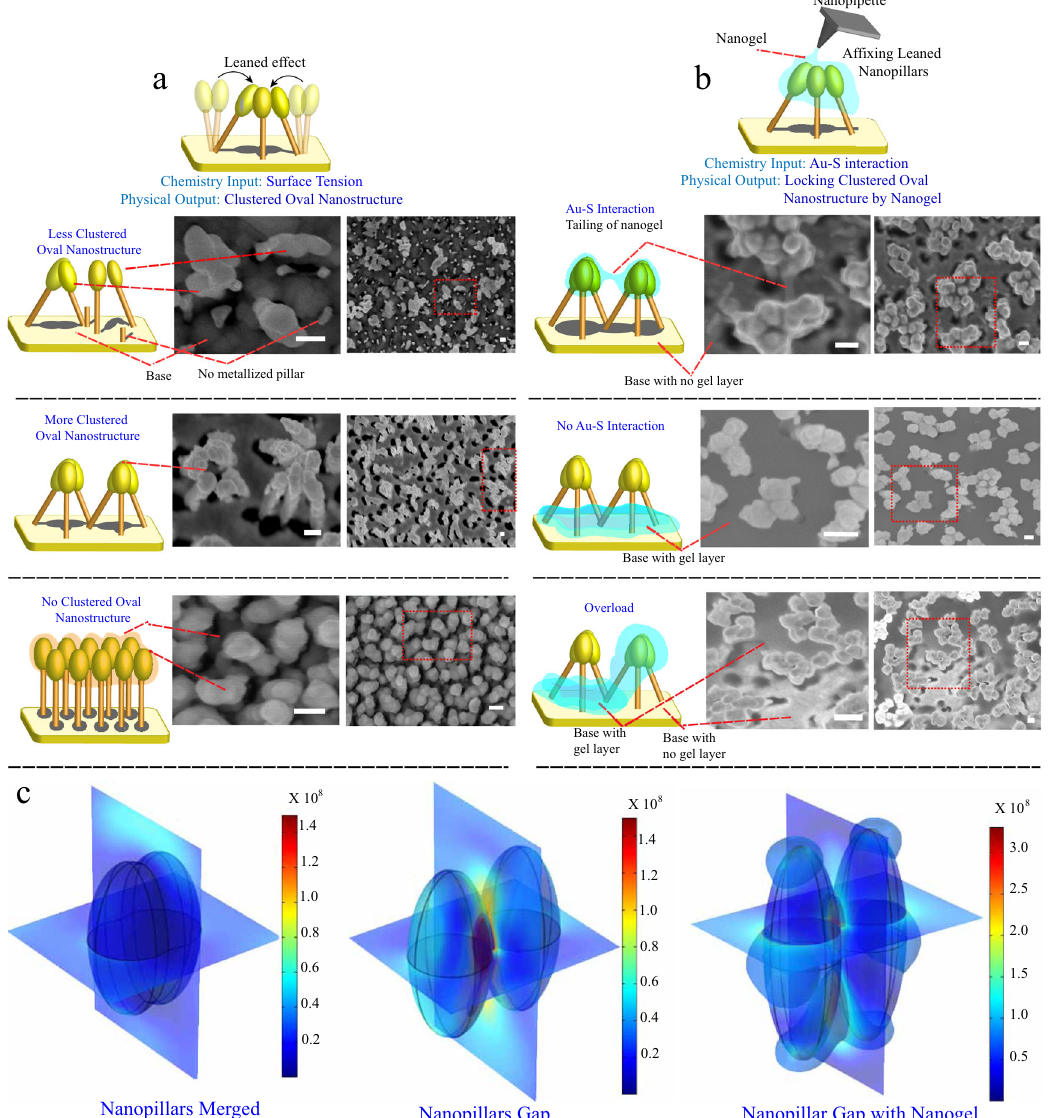
Fig. 3 Deposition nanogel on fabricated nanopillars. a The effect of the level of Au deposition on the formation of leaning nanopillars. A representative image of three individual experiments is shown (scale bar: 100 nm). b The importance of Au-thiol interactions for af fi xing leaning nanopillars on nanogels. A representative image of three individual experiments is shown (scale bar: 100 nm). c The importance of the gap between nanopillars and the deposition of nanogel shows no signi fi cant disruption to the electromagnetic wave of